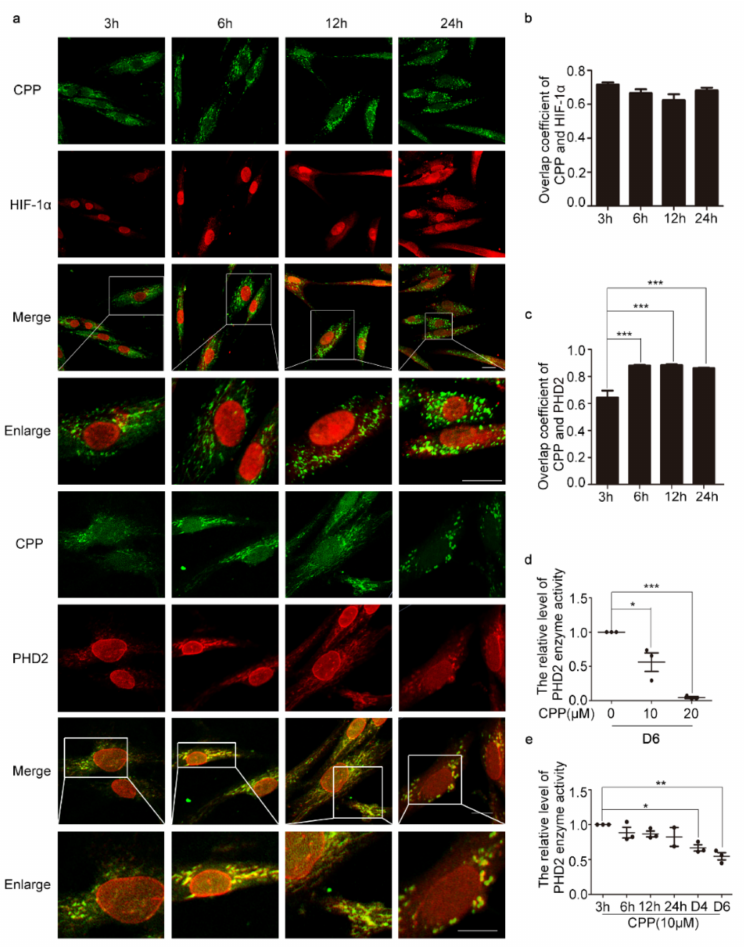
Figure 3. CPP inhibits PHD2 activity in HDFs. ( a – c ) HDFs were treated with CPP (10 µ M) for 3, 6, 12 and 24 h, after which immunofluorescence was used to detect the co-localization of CPP and HIF-1 α , or CPP and PHD2. Scale bars: 20 µ m. ( d , e ) CPP inhibited PHD2 activity in a dose- and time-dependent manner. HDFs were treated with CPP at 0, 10 or 20 µ M, for 6, 12, 24 h, or 4 days (D4) or 6 days (D6), respectively, after which the effects of CPP on PHD2 activity were measured using a PHD2 enzyme-linked immunoassay kit. Data are presented as means ± SEM, * p < 0.05, ** p < 0.01, *** p < 0.001, n =